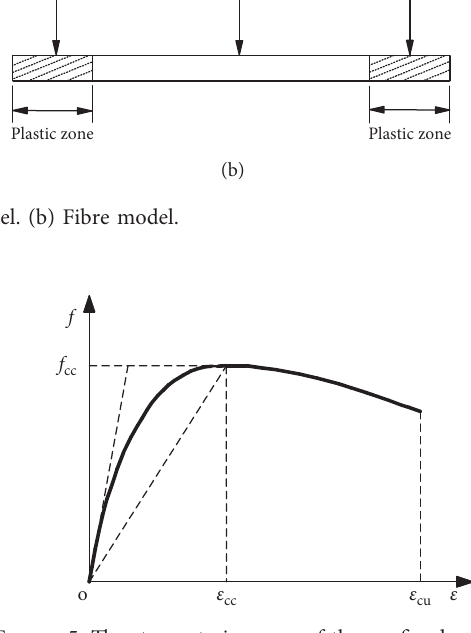
Figure 5: The stress-strain curve of the confined concrete.